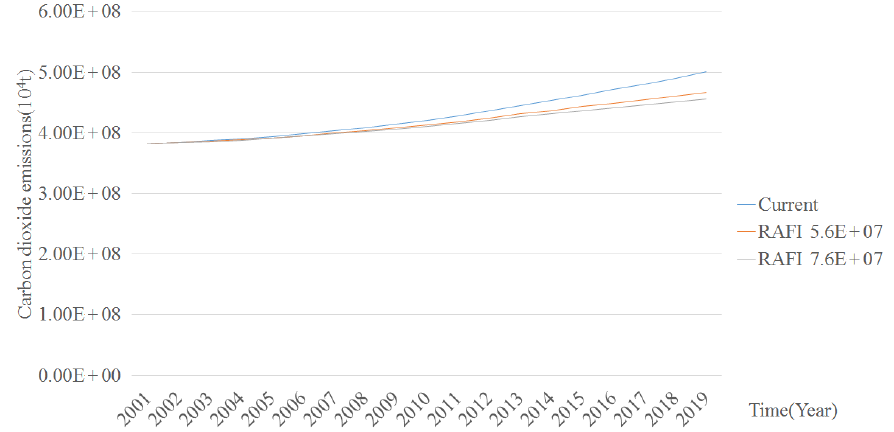
Figure 5. Carbon dioxide emissions in different railway freight environmental protection investment scenarios.